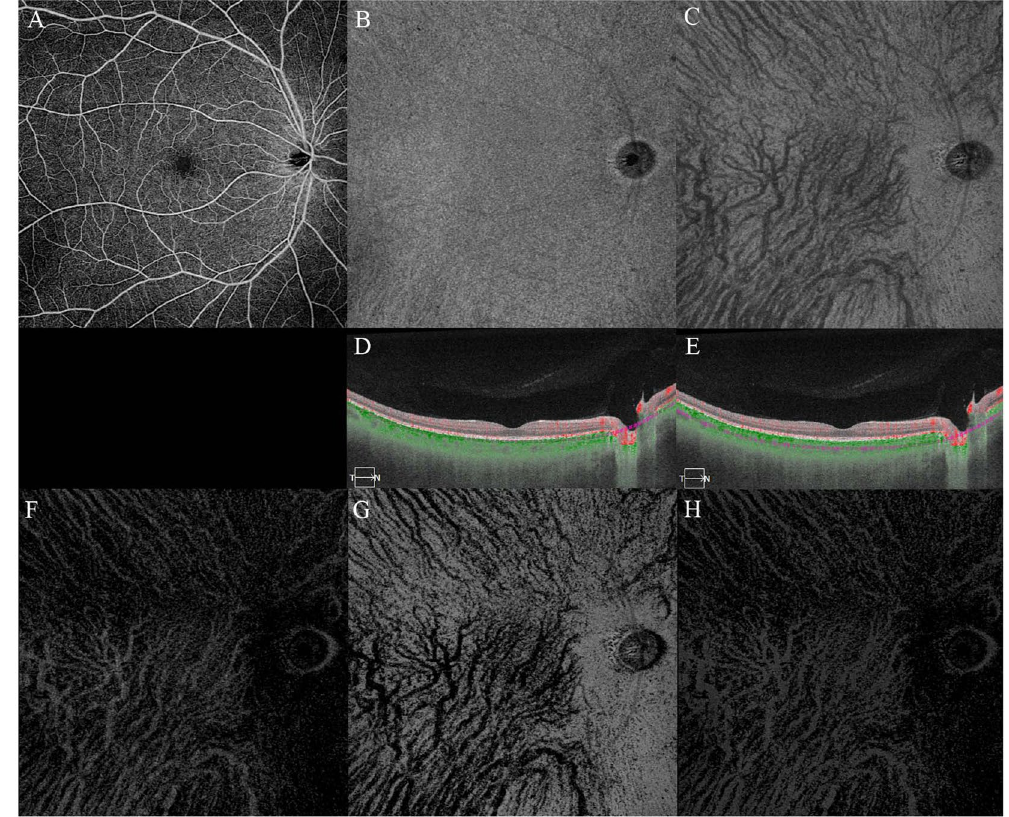
Figure 6. Subtraction of choriocapillary projection artifact. Case 1 was a 35-year-old man. Right eye. Brightness and contrast are adjusted for easier observations of these figures. ( A ) Swept source optical coherence tomography angiographic image of the entire retina. ( B ) Choriocapillaris image. ( C ) Half of the choroid image. ( D ) Cross sectional image with the segmentation boundaries set to the choriocapillaris. ( E ) Cross sectional image with the segmentation boundaries set to one-half of the choroid. ( F ) First subtracted image from the choriocapillaris by C. ( G ) Second subtracted image from the half-choroid by F. ( H ) Third subtracted image from half-choroid by E. Subfoveal choroidal thickness is 290 µ m. Ratio of flow area is